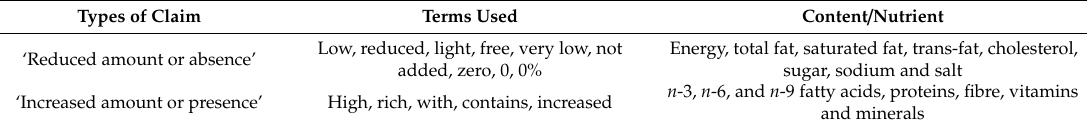
Table 1. Types of claims, terms, and content / nutrients identified as regulated Complementary Nutritional